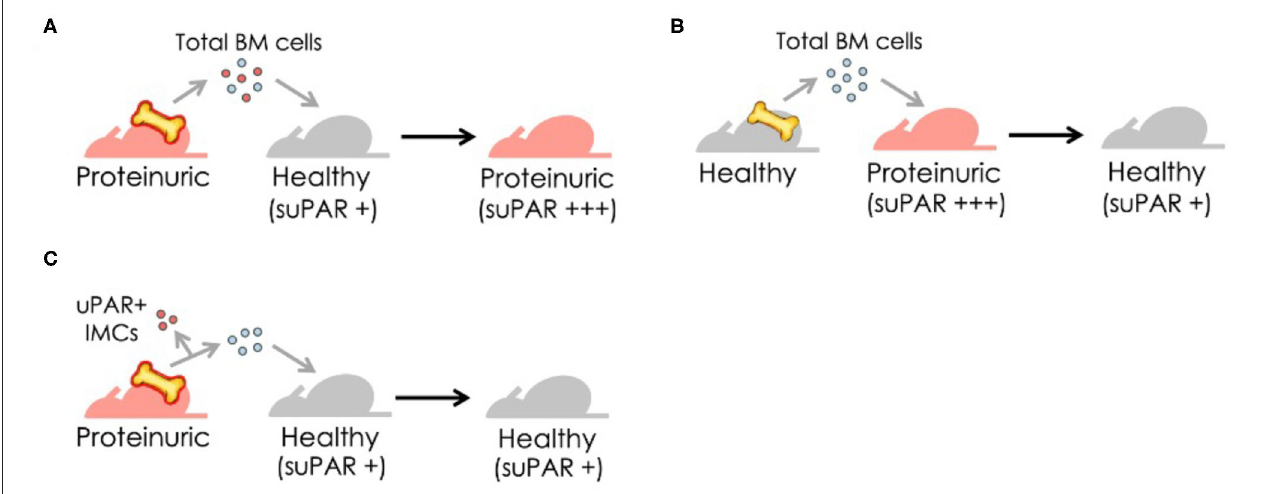
FIGURE 1 | Bone marrow (BM)-derived immature myeloid cells (IMCs), newly identified as a cellular source of suPAR, transfer disease from proteinuric to healthy mice. (A) Transfer of BM cells from proteinuric to healthy mice results in proteinuria and increases blood suPAR levels. (B) Replacement with BM cells from healthy mice significantly reduces suPAR levels and subsequently improves renal function in proteinuric mice. (C) The removal of uPAR-expressing IMCs prior to transfer of BM cells from proteinuric to healthy mice protects mice from proteinuria.